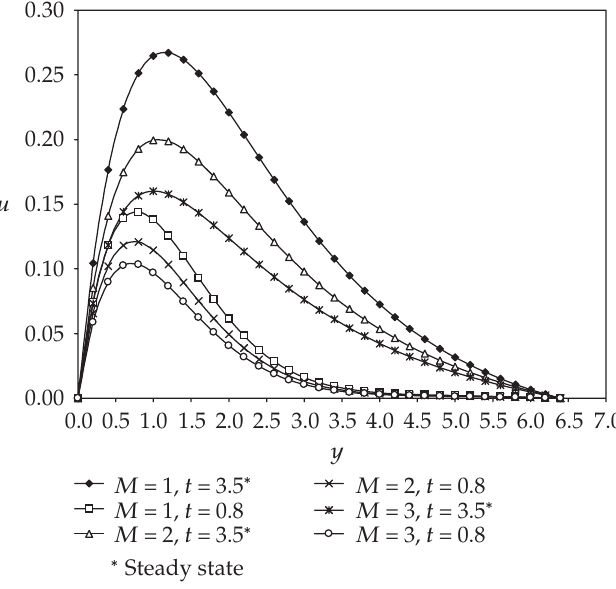
Figure 5.3 . Transient velocity profiles for the di ff erent values of M and for the values x = 1, F = 0 . 01, m = 1, and Pr = 0 .